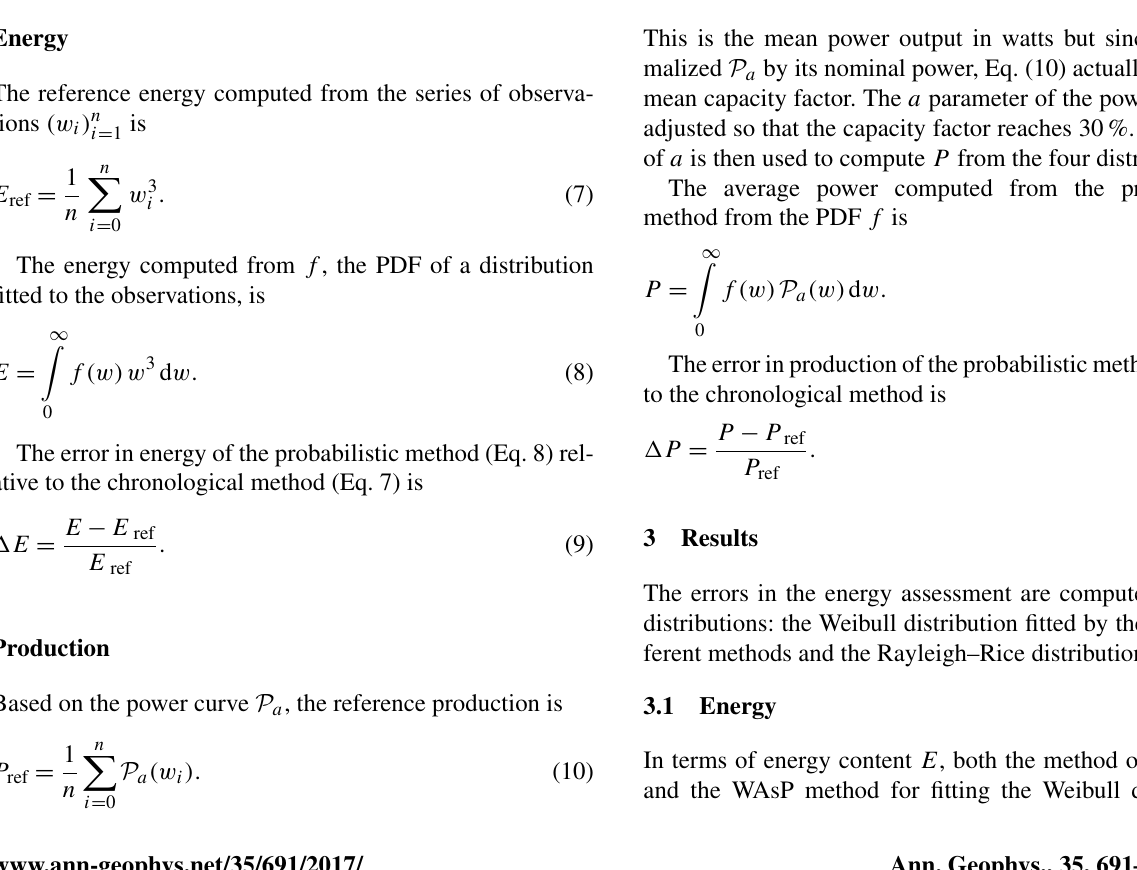
Figure 2. Maps of (cid:49)E , i.e., the relative errors in wind energy content due to the statistical modeling, at the 89 stations for either the Weibull distribution fit by maximum likelihood (a) or the Rayleigh–Rice distribution (b)